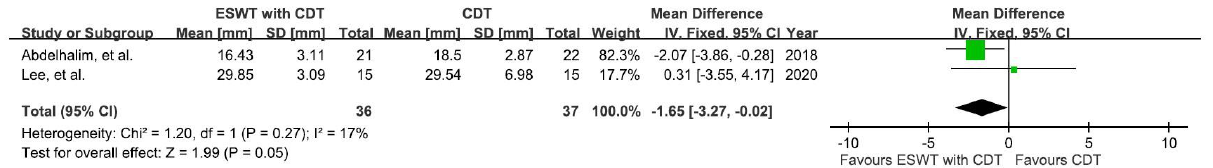
Figure 6. Mean difference (95%CI) in the effect of additional ESWT compared with CDT alone on the skin thickness of BCRL.